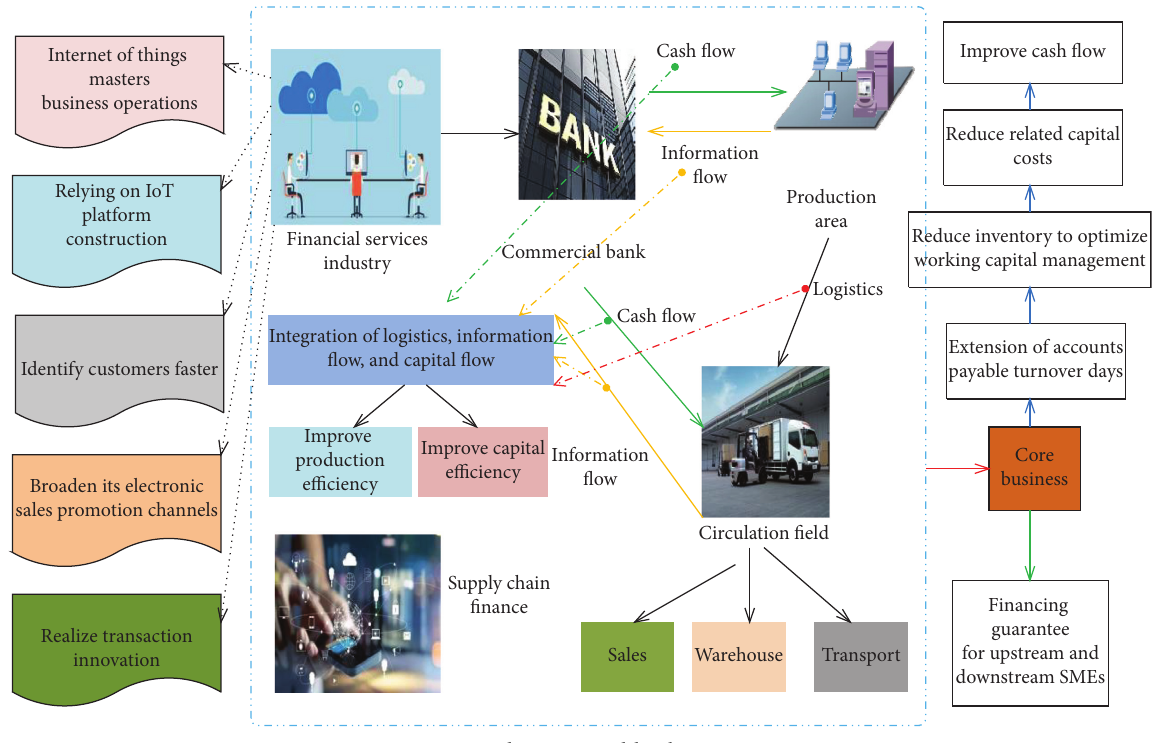
Figure 3: Financial commercial bank service process.